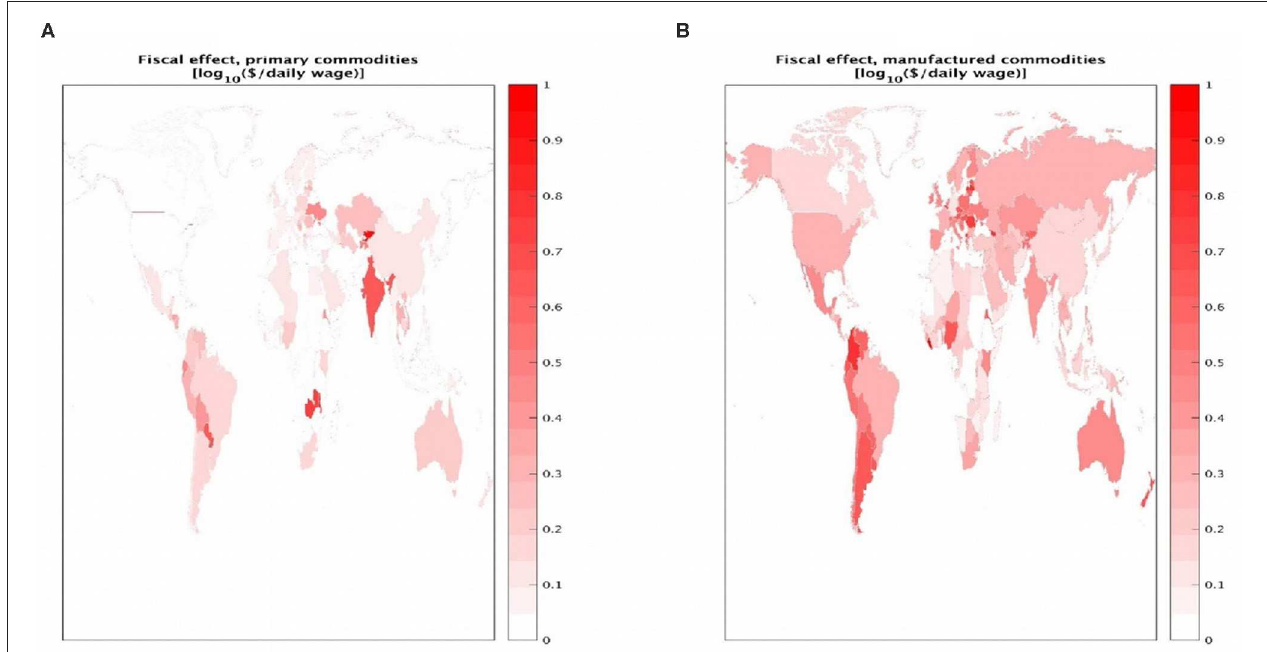
FIGURE 5 | Incidence of a 10% tax on a range of food items. Incidence of a 10% tax on the total output of a set of primary (A) and secondary food (B) items. To refer fiscal effects to a meaningful unit reflecting countries’ relative wealth, color shadings reflect multiples (1–10) of each country’s total daily wage payment. Left panel: Sugar beet, sugar cane, raw sugar, refined sugar. Right panel: Refined sugar, soft drinks, chocolate, ice cream, extracts.